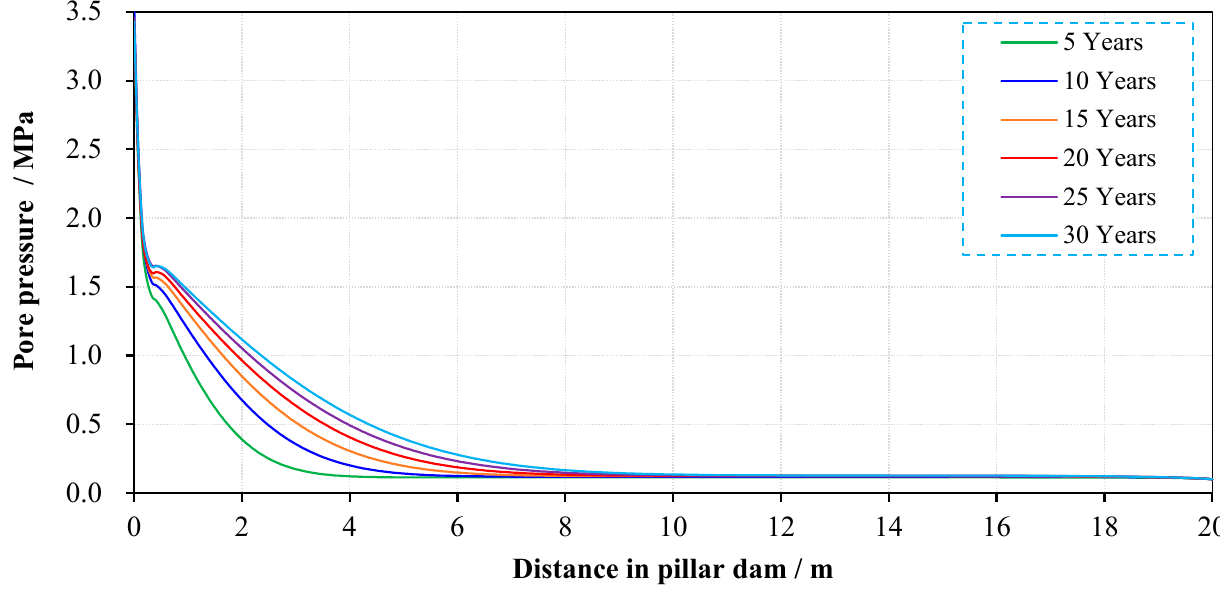
Figure 8. Distribution of pore pressure in the pillar during 30 years of operation.